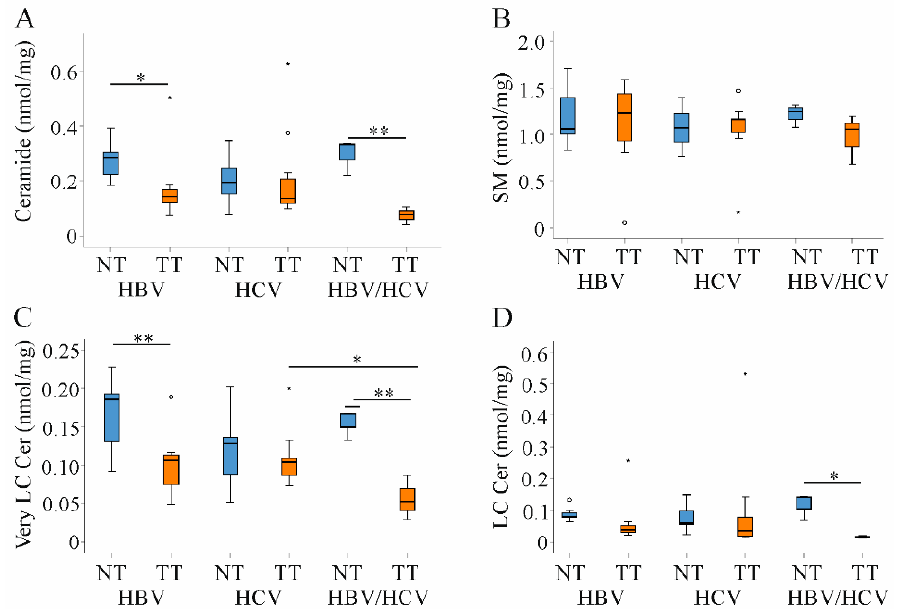
Figure 4. Ceramide (Cer) and sphingomyelin (SM) in non-tumor (NT, blue boxes) and tumor tissues (TT, orange boxes) of patients with HBV and HCV infection. ( A ) Ceramide; ( B ) SM; ( C ) Very long- chain ceramide (Very LC Cer) and ( D ) Long-chain ceramide (LC Cer) levels in NT and TT of HBV, HCV and double infected patients. Small circles and stars in the figures identify outliers. * p < 0.05, ** p < 0.01 (Kruskal-Wallis-Test).